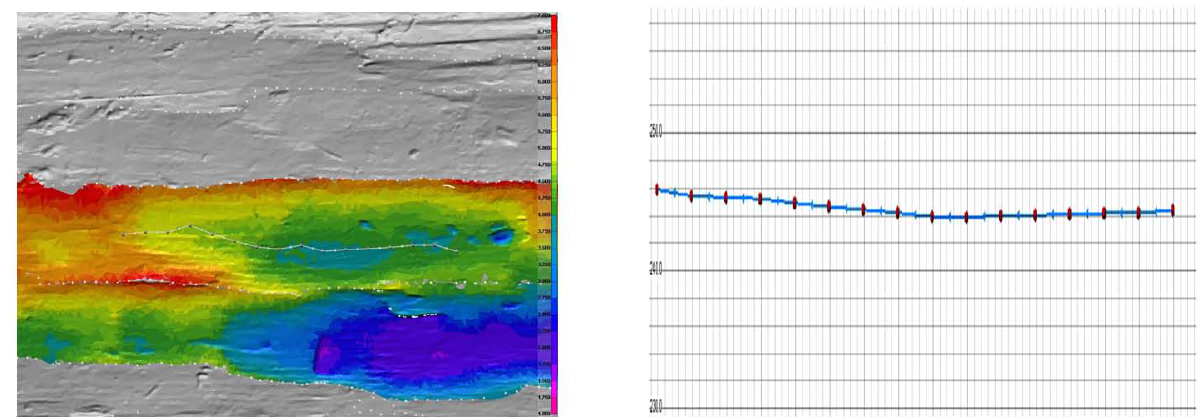
Figure 5. The visualisation of a hand tool movement’s trajectory - top view of the trajectory within an investigated facet (left), side view of the trajectory after the vertical scaling for better visualisation (right)